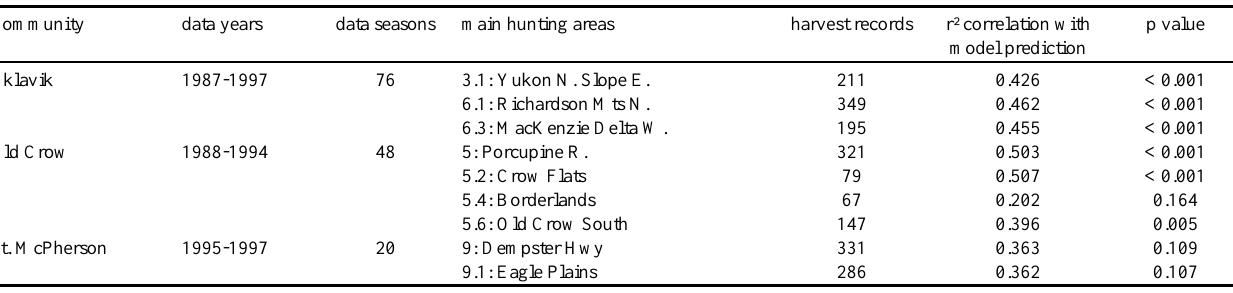
Table 6 . Partial correlation between simulated abundance of animals in a subzone during a given season and reported harvest by community for that same subzone and